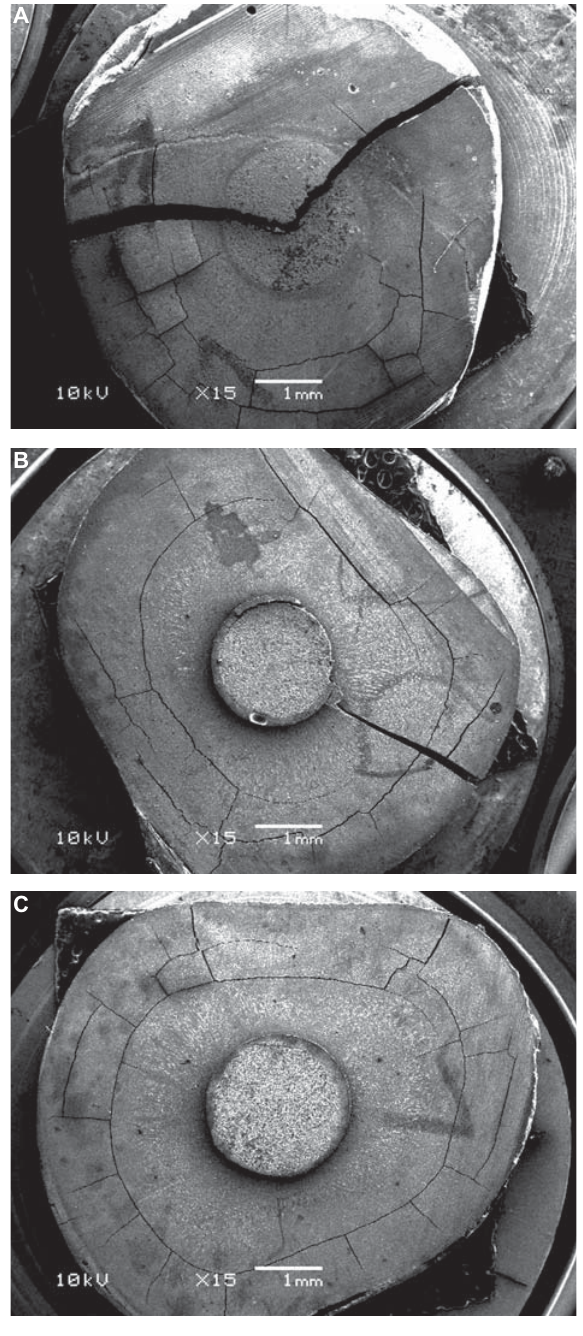
Figure 2- Scanning electron microscopy images. (A) Cohesive failure in dentine. (B) Mixed adhesive/cohesive failure. (C) Adhesive failure between dentin and cement